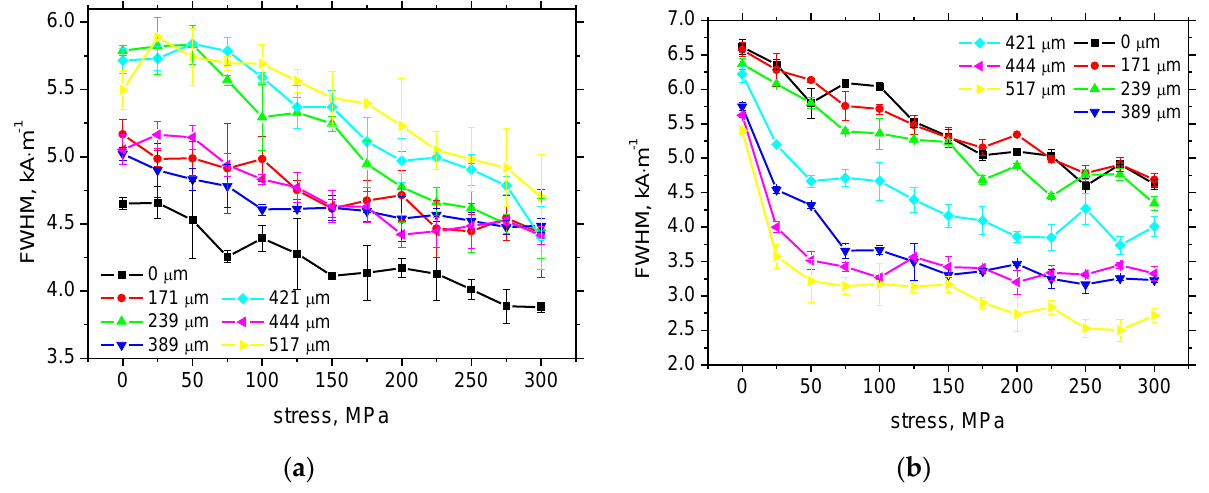
Figure 13. FWHM versus tensile stress for the different coating thickness. ( a ) RD and ( b ) TD.